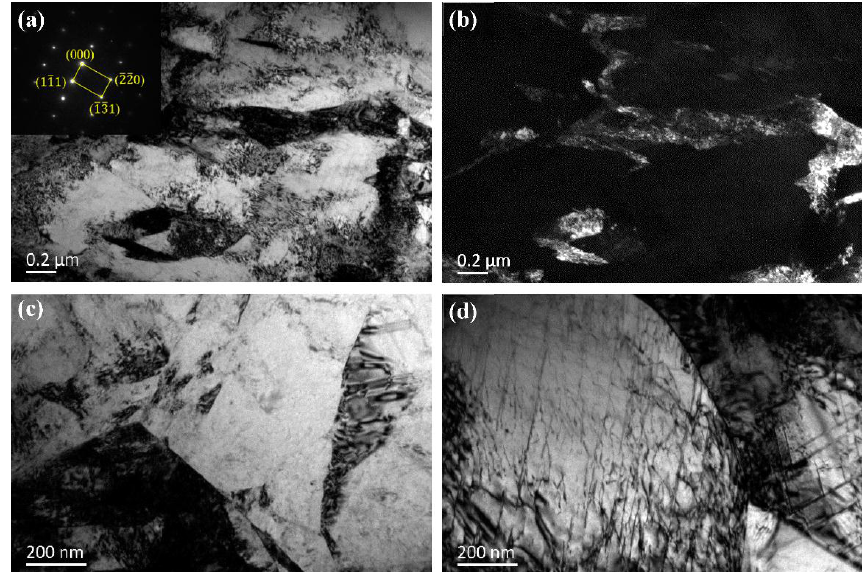
Figure 6. TEM microstructure of SZ: ( a ) bright-field and ( b ) dark-field TEM micrographs of the austenite and associated diffraction pattern; ( c ) low density and ( d ) high dislocation network structure.